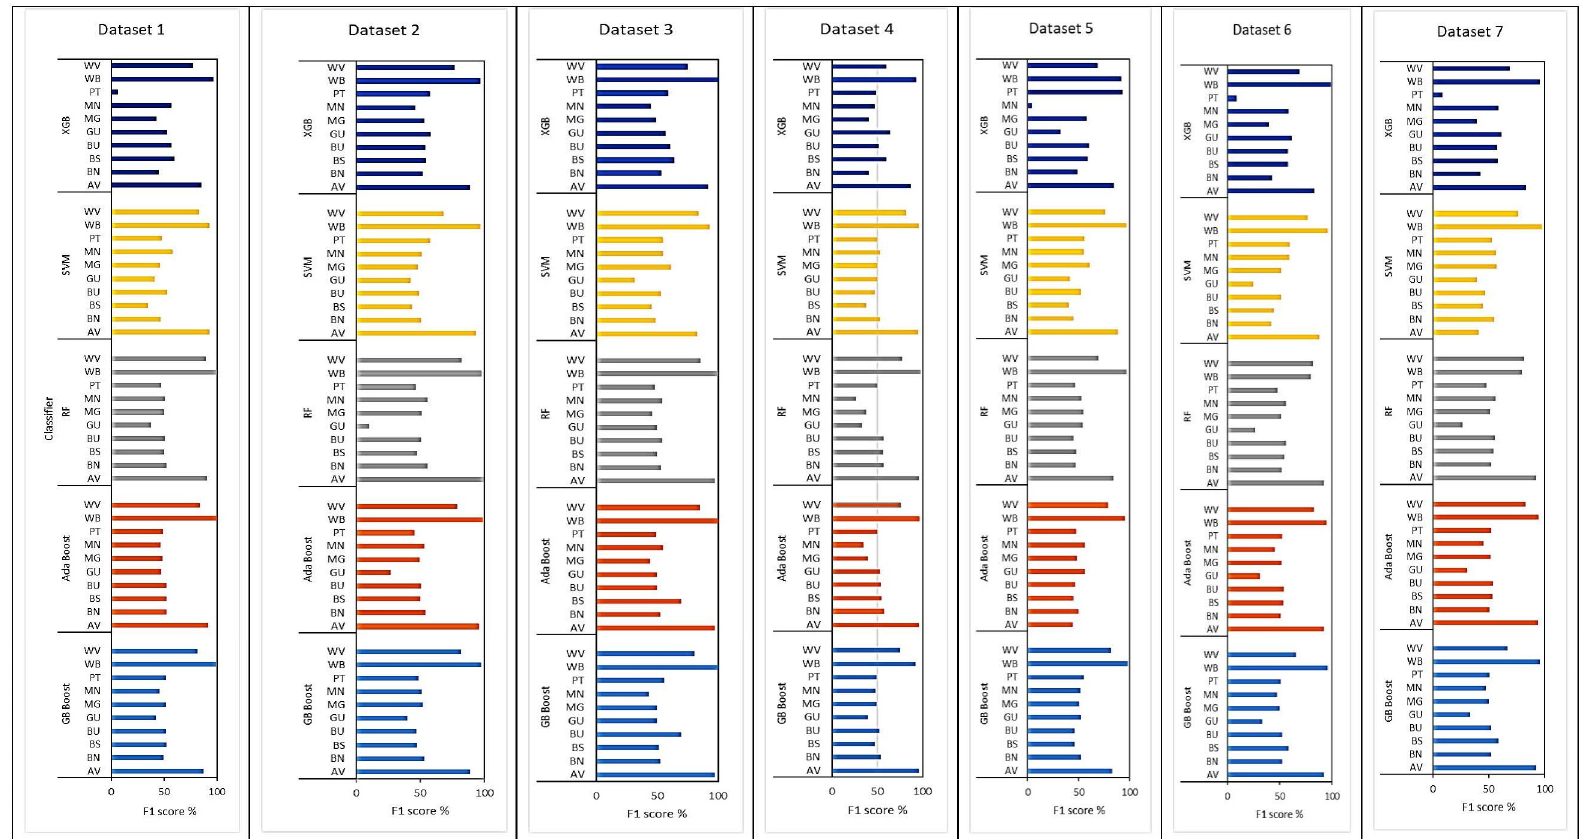
Figure 7. F1 ‐ scores rankings indicating the effect of sampling methods on class ‐ specific accuracies obtained from GB, Ada Boost, RF, SVM, and Figure 7. F1‑scores rankings indicating the effect of sampling methods on class‑specific accuracies obtained from GB, Ada Boost, RF, SVM, and XGBoost classifiers. XGBoost classifiers. The mapped classes are avocado (AV), banana (BN), bare soil (BS), built ‐ up (BU), guava (GV), macadamia nut (MN), mango The mapped classes are avocado (AV), banana (BN), bare soil (BS), built‑up (BU), guava (GV), macadamia nut (MN), mango (MG), pine tree (PT), water body (WB), (MG), pine tree (PT), water body (WB), and woody vegetation (WV). and woody vegetation